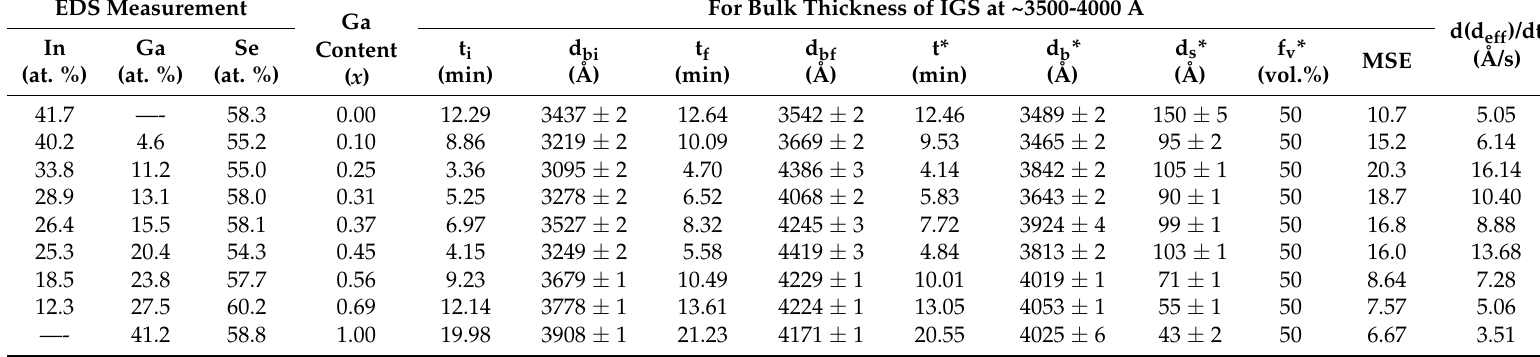
Table 1. EDS results for the IGS films of the composition series. Additional columns tabulate the selected time ranges defined by the initial times t i and the final times t f , as well as the inversion times (or center times) t*, used for multi-time analysis of RTSE data collected during the deposition of IGS with different compositions. This RTSE analysis is used to determine the ( ε 1 , ε 2 ) spectra of IGS, assuming a b-spline model, along with the evolution of the bulk and surface roughness layer thicknesses d b and d s , respectively. The best fit results for d b are given at t i , t* and t f of the multi-time analysis; the best fit results for d s and the fixed value of the void content f v in the IGS surface roughness layer are given at t*; and the values describing the fitting quality are presented as the mean-square errors, MSE. The effective deposition rates, tabulated as the time derivatives of the effective thickness (IGS film volume/area) at t*, are provided in the last column. In most cases, these effective deposition rates are larger than (d b * + 0.5d s *)/t* since the latter average rate does not include the time-independent interface IGS contribution of d i f IGS and in addition, variations in rate can occur throughout the